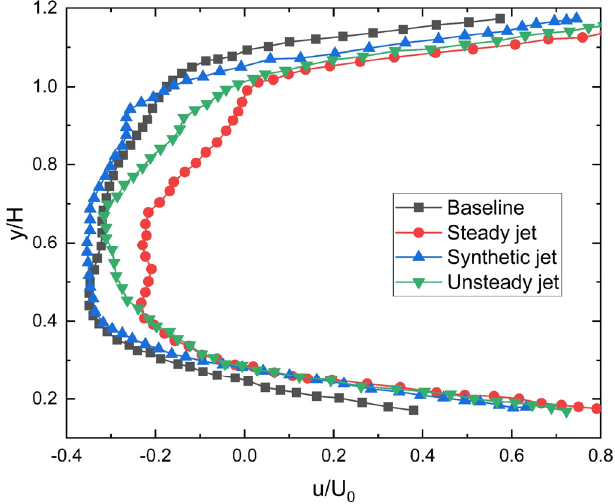
Figure 15. Vertical normalized streamwise velocity profiles measured at x/H = 0.5 in the symmetry plane, with different actuator types.